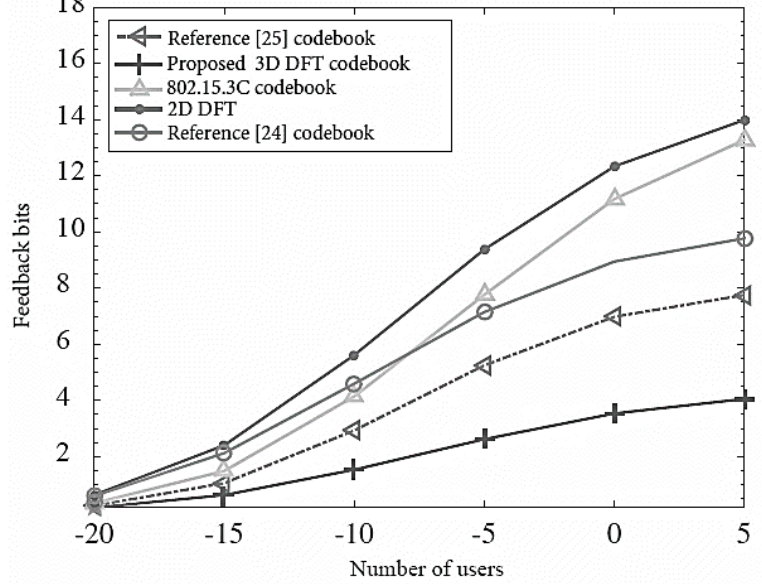
Figure 12. Comparison of feedback bits versus the number of users for the proposed 3D codebook scheme and other state-of-the-art schemes.